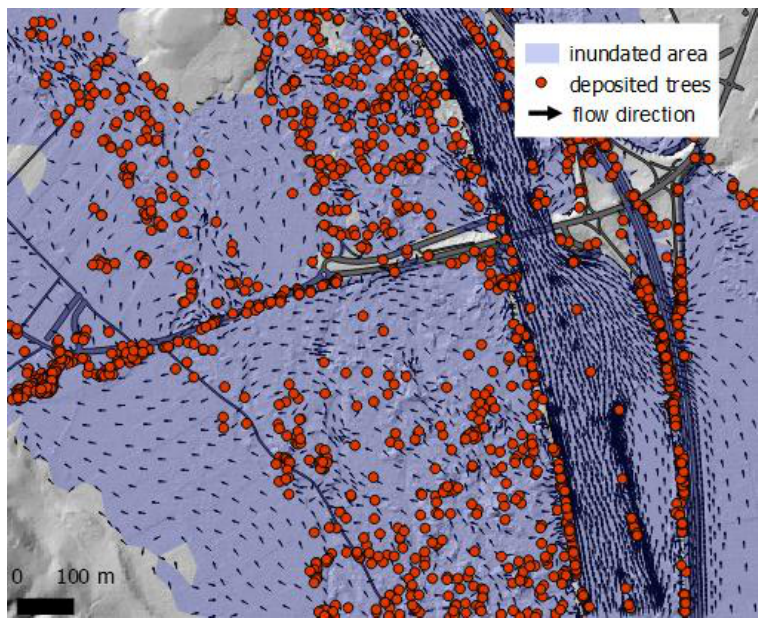
Figure 5. Extract of the map of the deposition areas in the Aare River floodplain near Rubigen. Background map: Federal Office of Topography SWISSTOPO.